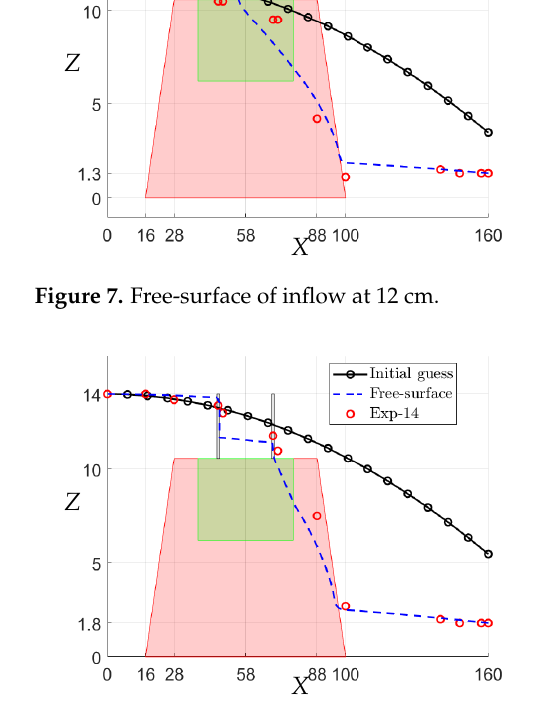
Figure 8. Free-surface of inflow at 14